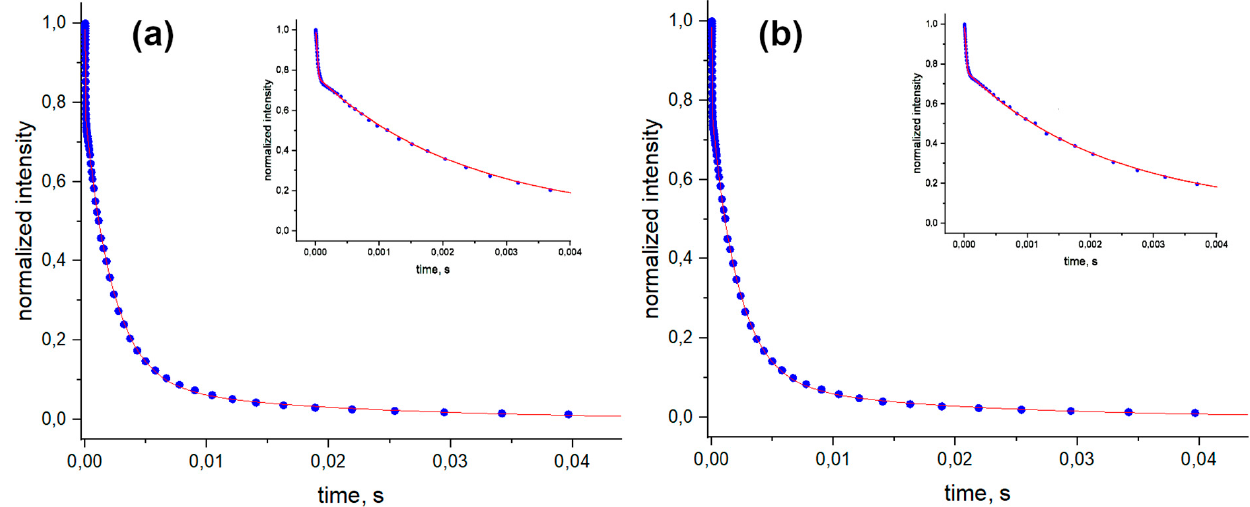
Figure 5. 1 H NMR T 2 relaxation decay for samples I ( a ) and II ( b ) (the films casted from toluene) measured at 25 °C using Hahn-echo pulse sequence. The solid lines represent the results of least- squares fitting of the decay (points) using linear combinations of Gaussian and exponential functions (see text for details).